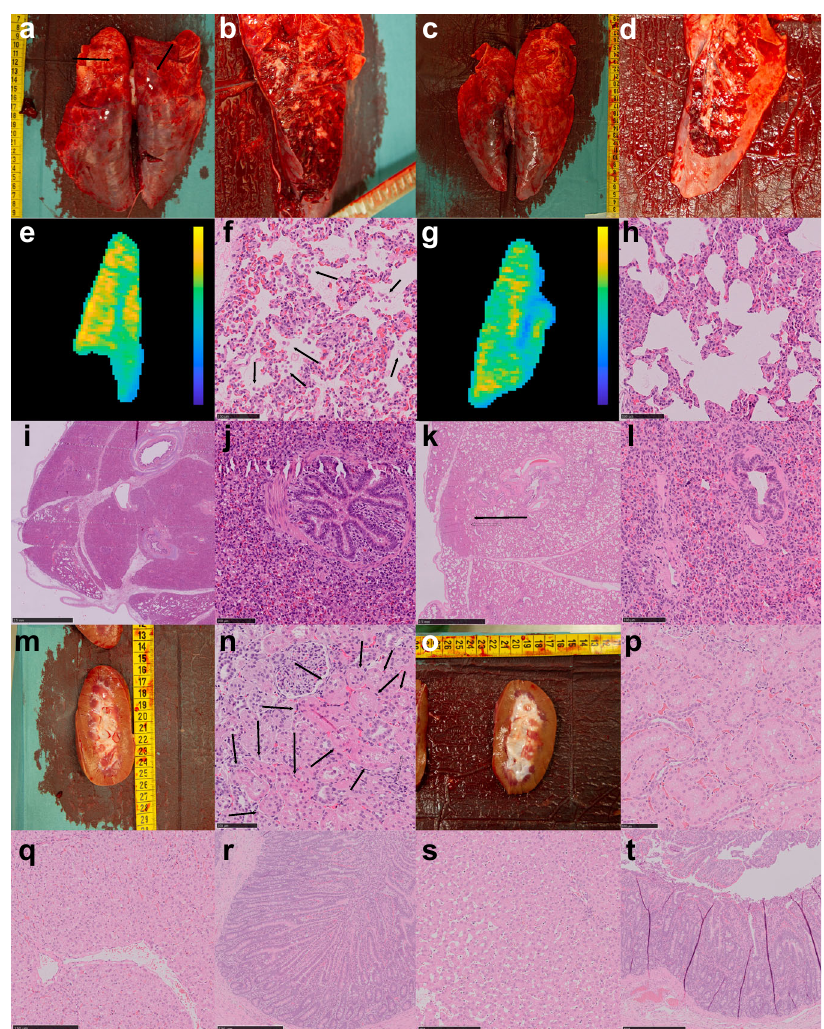
Fig. 8 Macroscopic and histological postmortem examination. a Model lungs. Image of posterior aspect with discoloring. b Coronal cut through the posterior aspect of the model lung. c Control lungs. Image of posterior aspect. d Similar coronal cut of a control lung. e The dominating microscopic image in the model lungs was blood stasis in vessels of all sizes. This corresponded to areas with stasis perfusion as illustrated by a parametric max enhancement map from the same model animal (yellow is higher contrast enhancement). f High power magni fi cation (x40) with fl uids in the alveolar sacs and sloughing of pneumocytes into the alveolar space (marked by arrows), consistent with early diffuse alveolar damage (scale bar 100 µ m). g Parametric relative contrast enhancement, with same color lookup table setting as in e , of control animal. h High power magni fi cation showing a fl uid collection in control lung (marked by arrow) in the alveolar sacs (scale bar 100 µ m). i The macroscopic texture of the model lung was rubbery. Large areas of the model lungs were fully consolidated (scale bar 2.5 mm). j Fluids and cells in bronchi in a fully consolidated model lung (scale bar 100 µ m). k In small areas in the most posterior aspects of the model lungs we could also identify fully consolidated lung (arrow, scale bar 2.5 mm). l Ventilated bronchi in fully consolidated control lungs (scale bar 100 µ m). m Model kidney. n Histological sample from model kidney with narrowing of proximal tubule wall thickness and sloughing of epithelial cells (arrows), consistent with acute tubular necrosis (scale bar 100 µ m). o Control kidney. p Control kidney without signs of acute tubular necrosis (scale bar 100 µ m). q Model liver without histological damage (scale bar 250 µ m). r Model small bowel (scale bar 500 µ m). s Control liver (scale bar 250 µ m). t Control small bowel (scale bar 500 µ